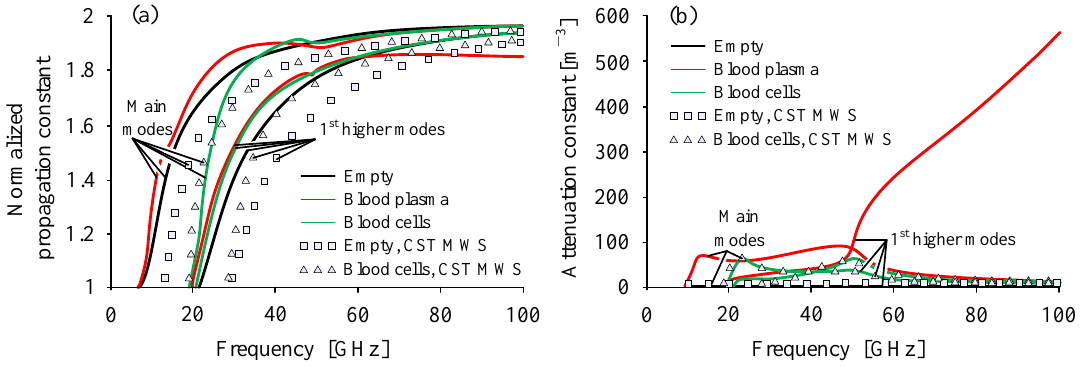
Figure 3. Normalized propagation constant h′/k ( a ) and attenuation constant h′′ ( b ) as functions of frequency for the fundamental and the first higher “tube” modes in an empty waveguide or that filled with blood components; r = 1 mm, R = 5 mm. Calculations using CST MWS for the empty waveguide and the one filled with blood cells are marked by squares and triangles respectively.